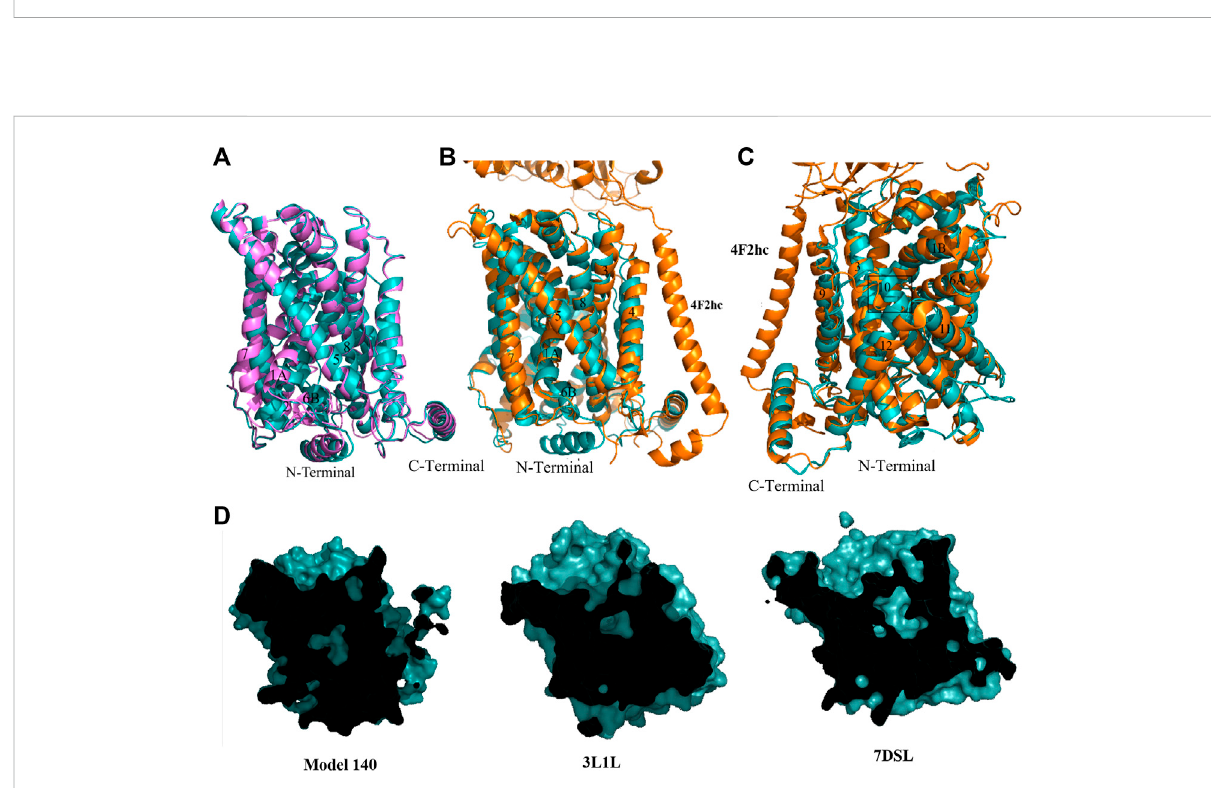
FIGURE 4 Homology model of xCT outward occluded conformation. (A) Overlay of model 283 (pink) and model 140 (cyan). (B) Overlay of model 140 (cyan) and Cryo-EM outward-occluded structures of human LAT1 with bound inhibitor JX-078 (PDB code: 7DSL, orange) from intracellular side. (C) Overlay of model 140 (cyan) and Cryo-EM outward-occluded structures of human LAT1 (7DSL) from extracellular side. (D) Sliced-surface representationsofthemodel 140 andAdiCandhumanLAT1outwardfacingoccludedsubstrate-boundstructure(3L1Land7DSL,respectively).